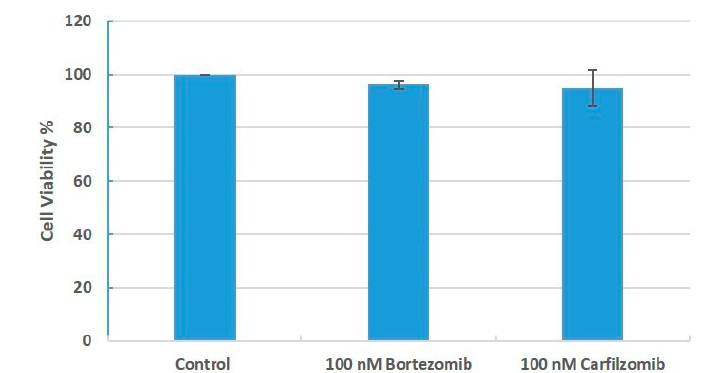
Figure 1. Percentage viability of human neuronal cells after 24 h of BTZ and CFZ treatments with WST-1 assay. Values represent means ± SD, n = 3.